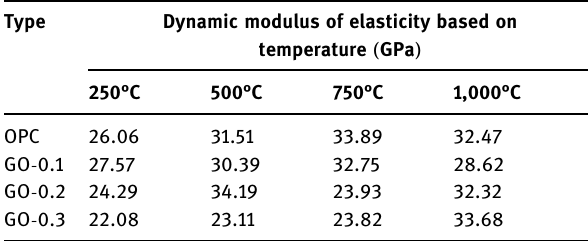
Table 4: Dynamic modulus of elasticity of the specimens Type Dynamic modulus of elasticity based